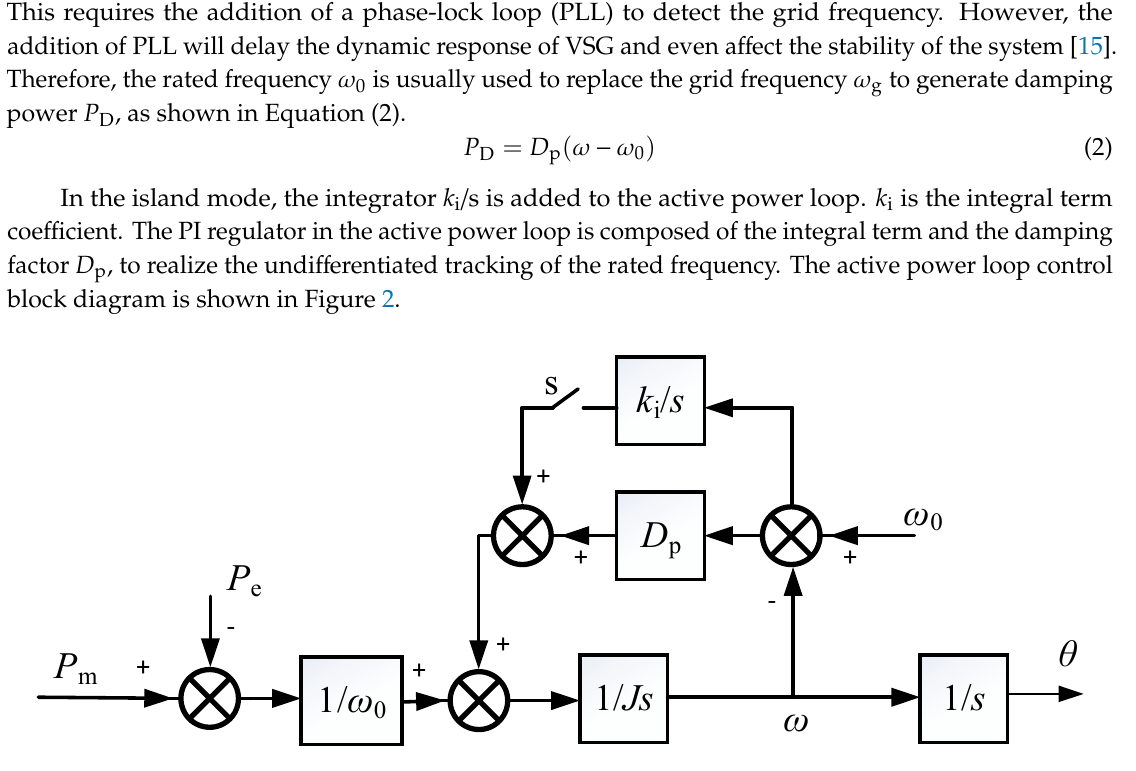
Figure 2. The active-power loop of VSG with the function of secondary frequency regulation.